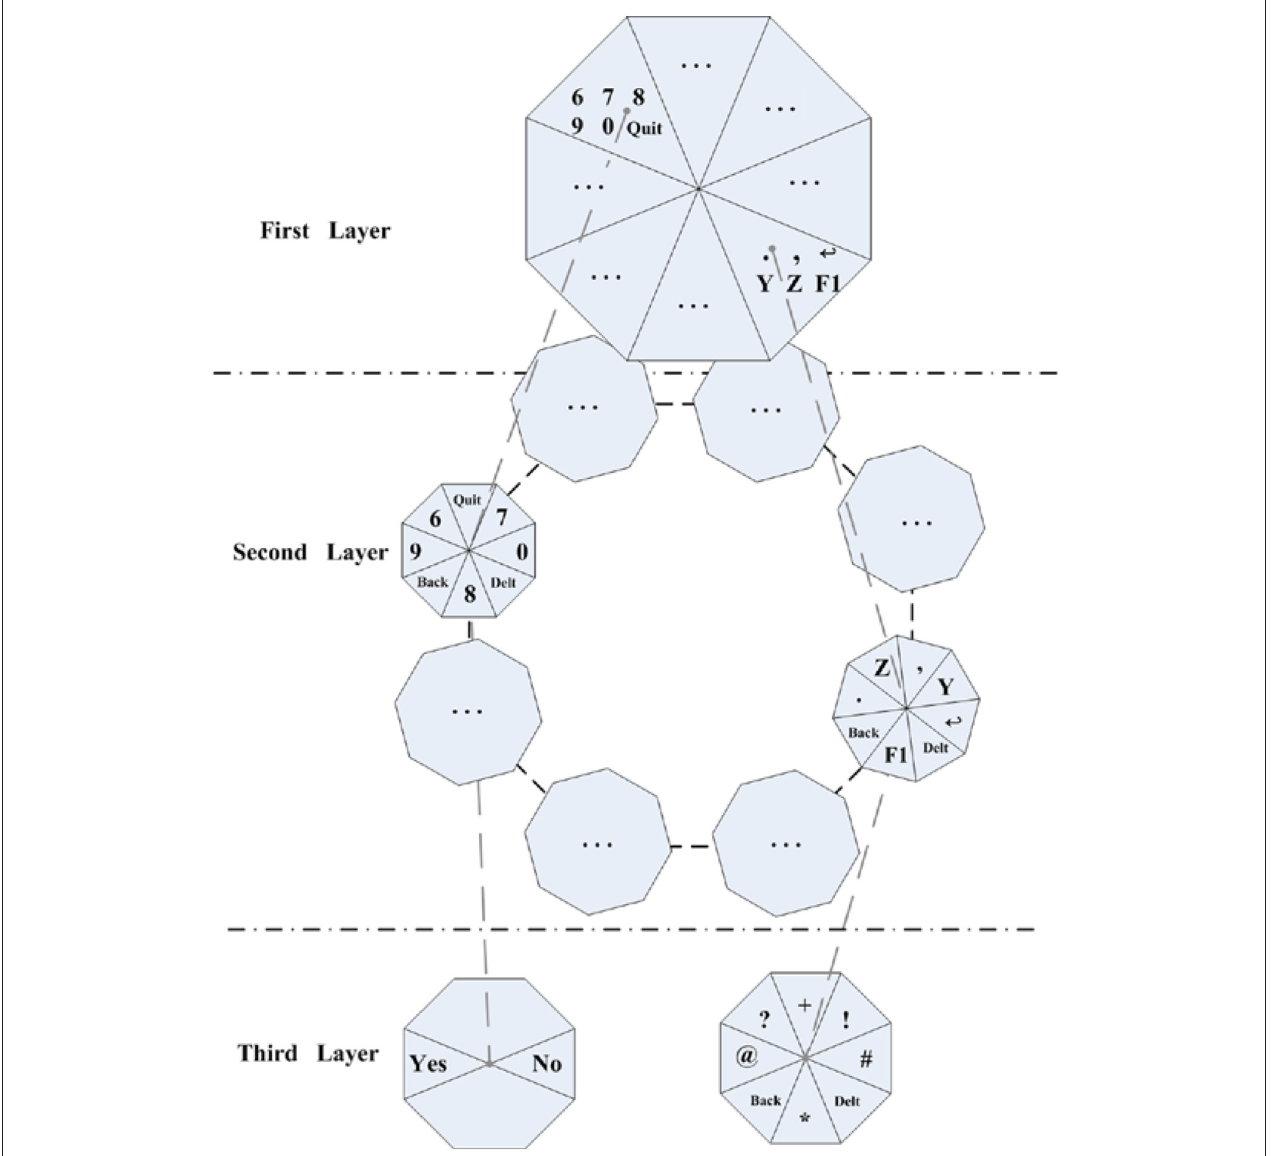
FIGURE 1 | In the first layer, 26 letters, 10 digits, and 6 symbols are divided into eight blocks. In the second layer, 7 different interfaces are designed to unfold the blocks in the above layer. Only two symbols are connected to the third layer. The subject can select the associating word by numeric option layer by